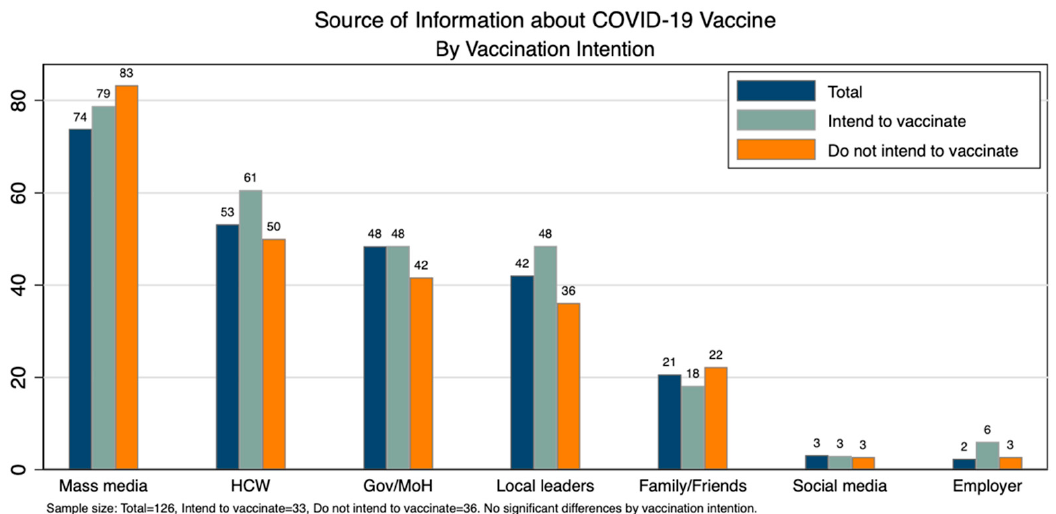
Figure 3. Source of information about COVID-19 Vaccine.